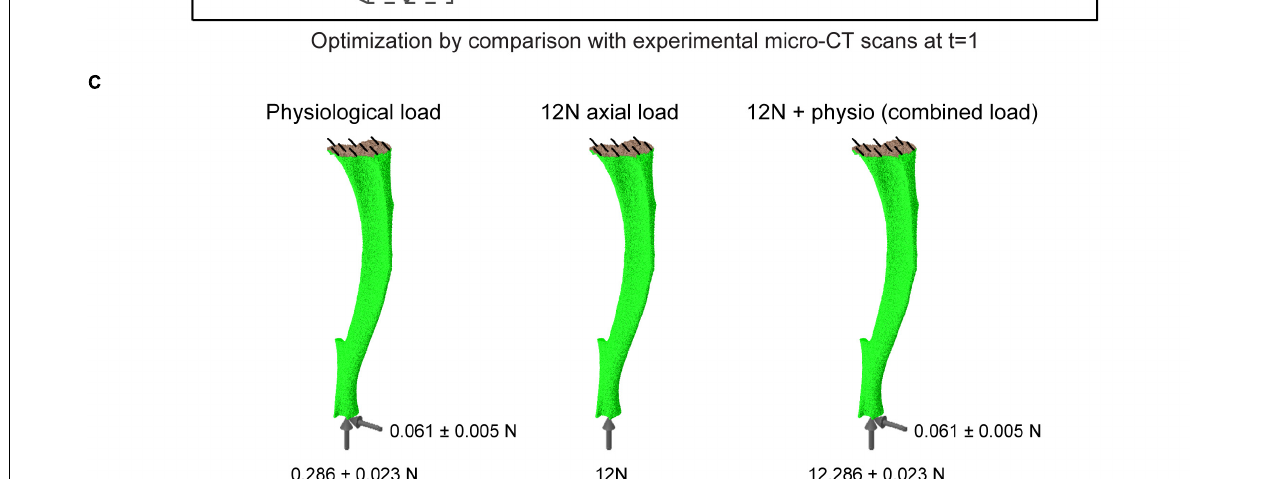
sub-regions of the tibia. All data analysis and graph